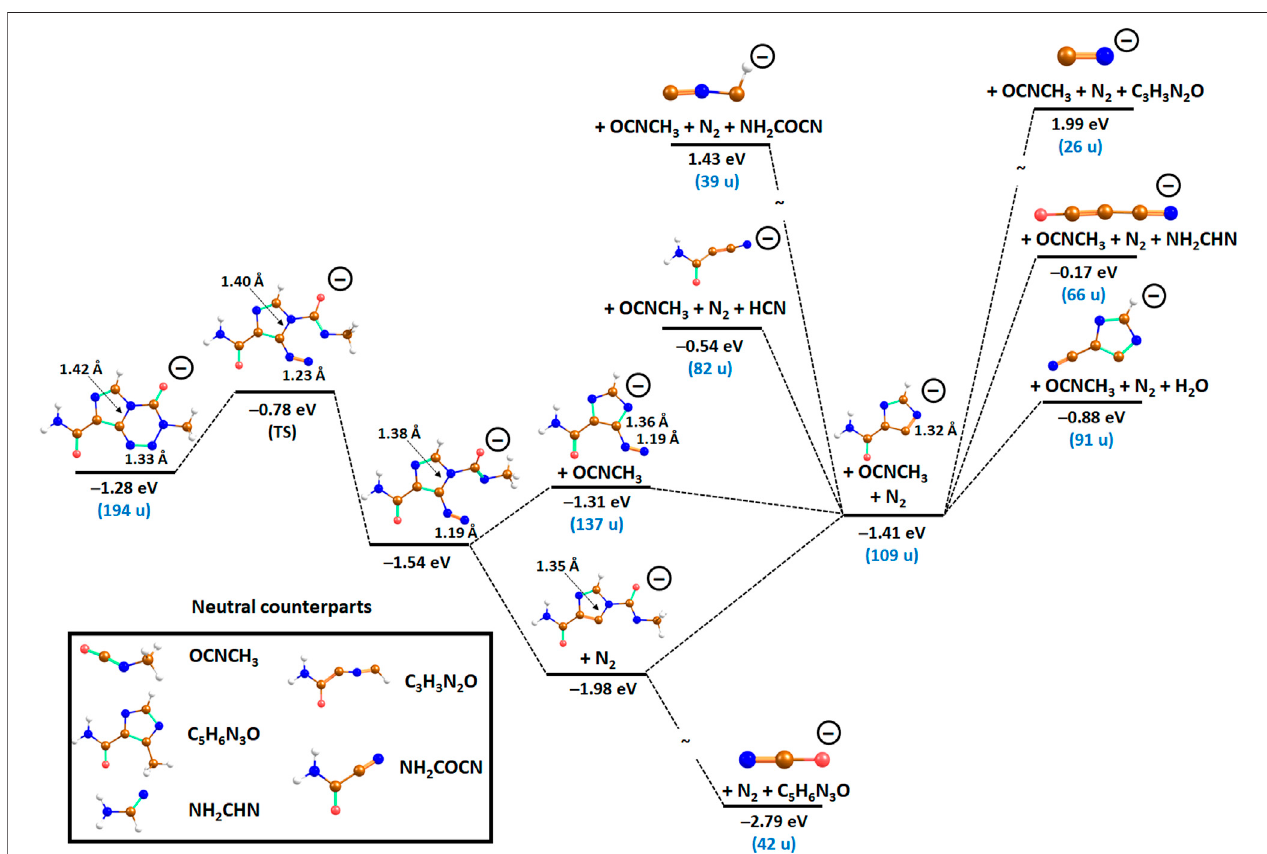
FIGURE 3 | Suggested reaction pathways in TMZ – as analyzed at the CCSD/aug-cc-pVDZ//B3LYP/aug-cc-pVDZ level along with selected bond lengths. Mass is shown for the parent anion and experimentally observed fragments. Color code: brown – carbon, blue – nitrogen, red – oxygen, white – hydrogen.